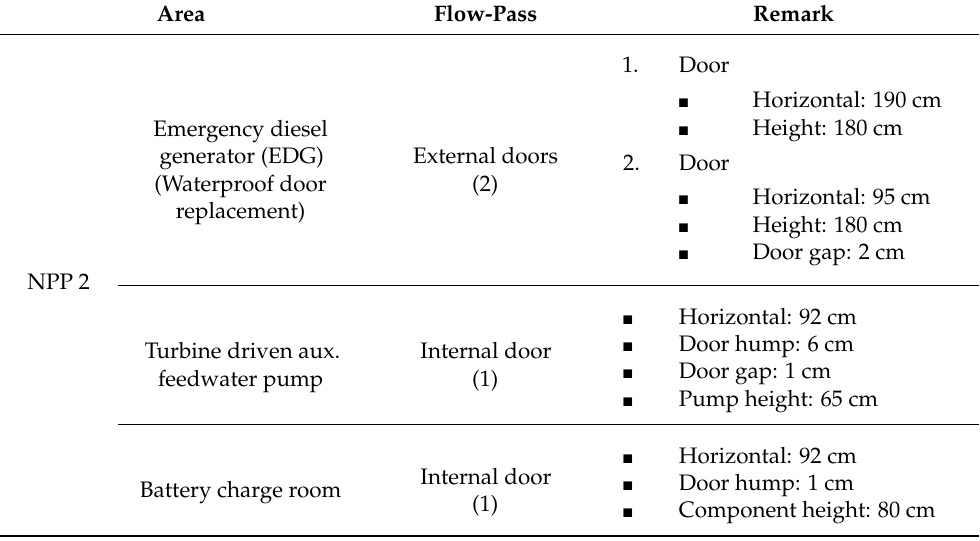
Table 1. Walkdown results of NPP